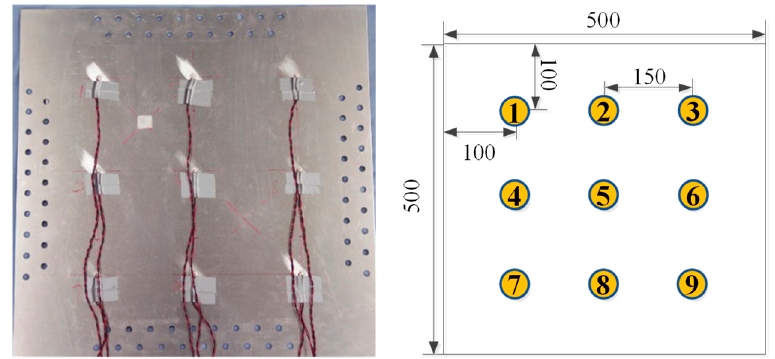
Figure 7. The aluminum plate with the PZTs and placement of the PZTs network.